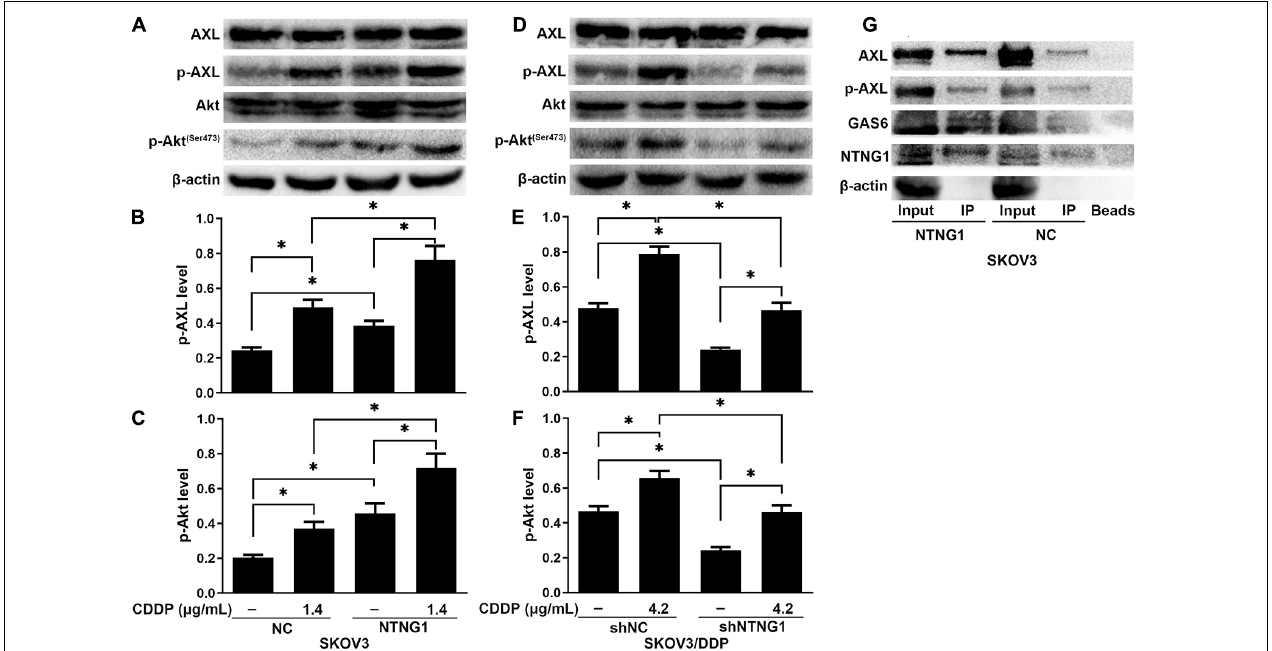
FIGURE 5 | NTNG1 bound GAS6/AXL to activate the AXL/Akt pathway ( n = 3). (A–F) AXL, p-AXL, Akt, and p-Akt were assayed by western blotting; the levels of p-AXL and p-Akt were increased following cisplatin exposure, indicating these molecules were involved in cell survival; such an inductive effect was enhanced in SKOV3 cells following overexpression of NTNG1 but was suppressed in SKOV3/DDP cells after silencing NTNG1. (G) Co-immunoprecipitation in SKOV3 cells; proteins were assayed by western blotting; the immunoprecipitate contained NTNG1, GAS6, and AXL/p-AXL; higher levels were noted following overexpression of NTNG1, confirming an interaction between NTNG1 and GAS6/AXL. CDDP, cisplatin. ∗ p <